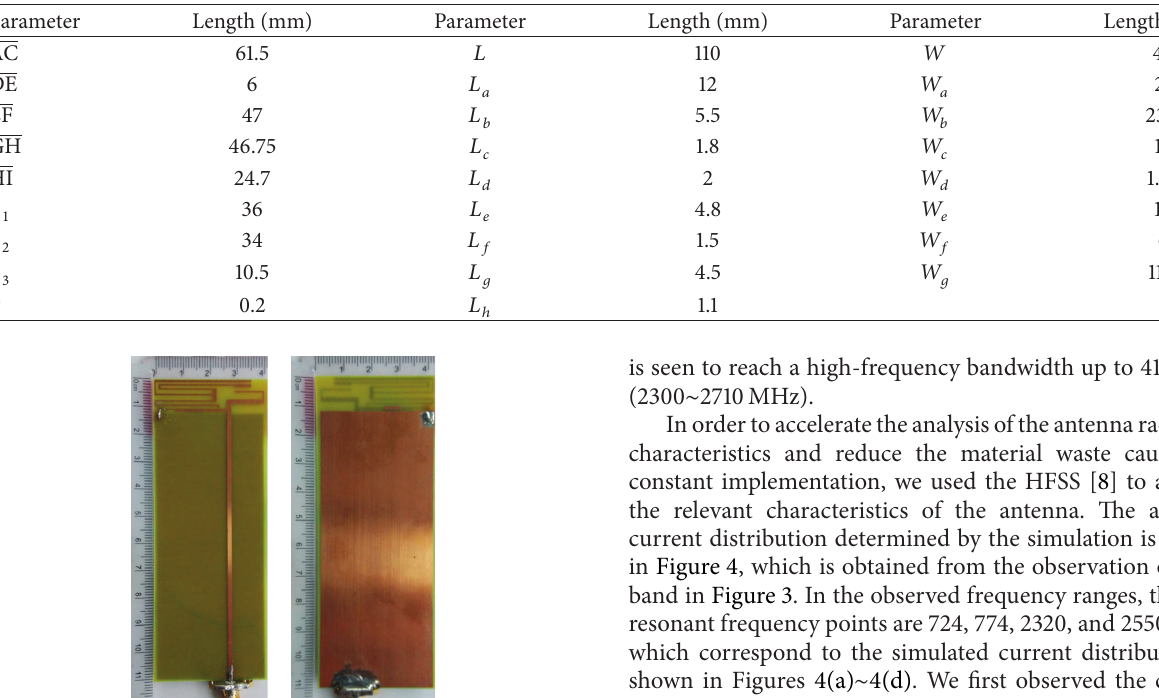
Table 1: The detailed dimension of the parameters in Figure 1.